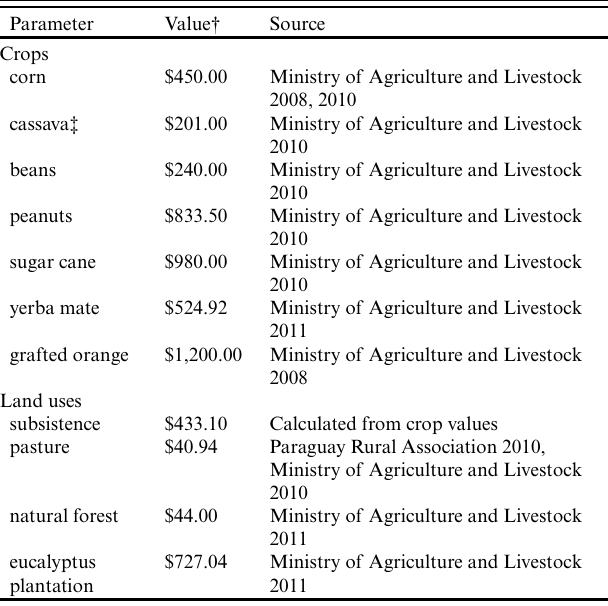
Table 2 . Estimates of gross income ($U.S./ha/yr) for individual crops and land-use